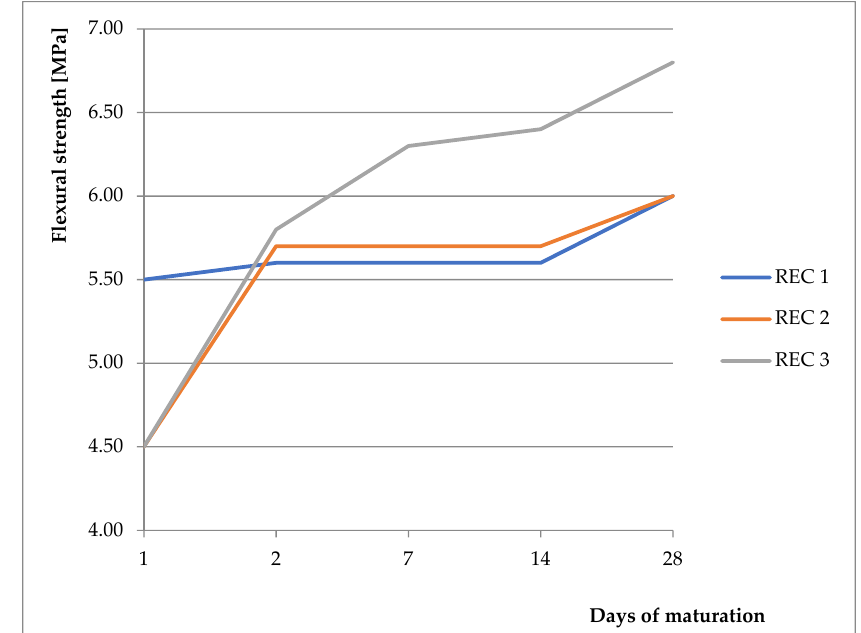
Figure 5. Flexural strength of prepared mixtures. Table 4. Mixture compositions. Recipe of the raw material values is given in [g and wt%]. Mixture